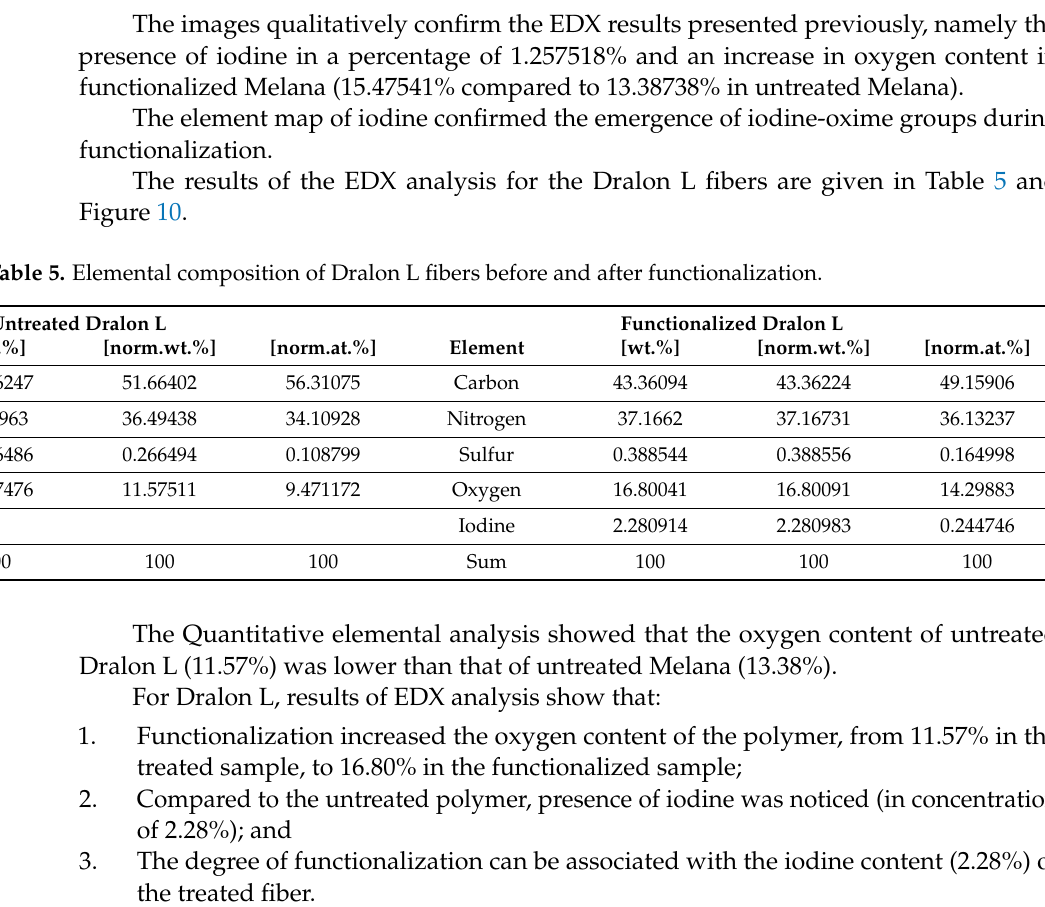
Table 5. Elemental composition of Dralon L fibers before and after functionalization. Untreated Dralon L